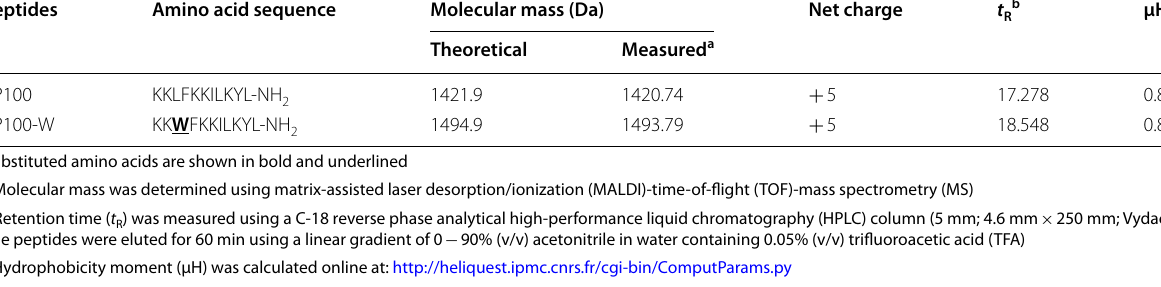
Table 1 Amino acid sequences and physicochemical properties of BP100 and BP100-W